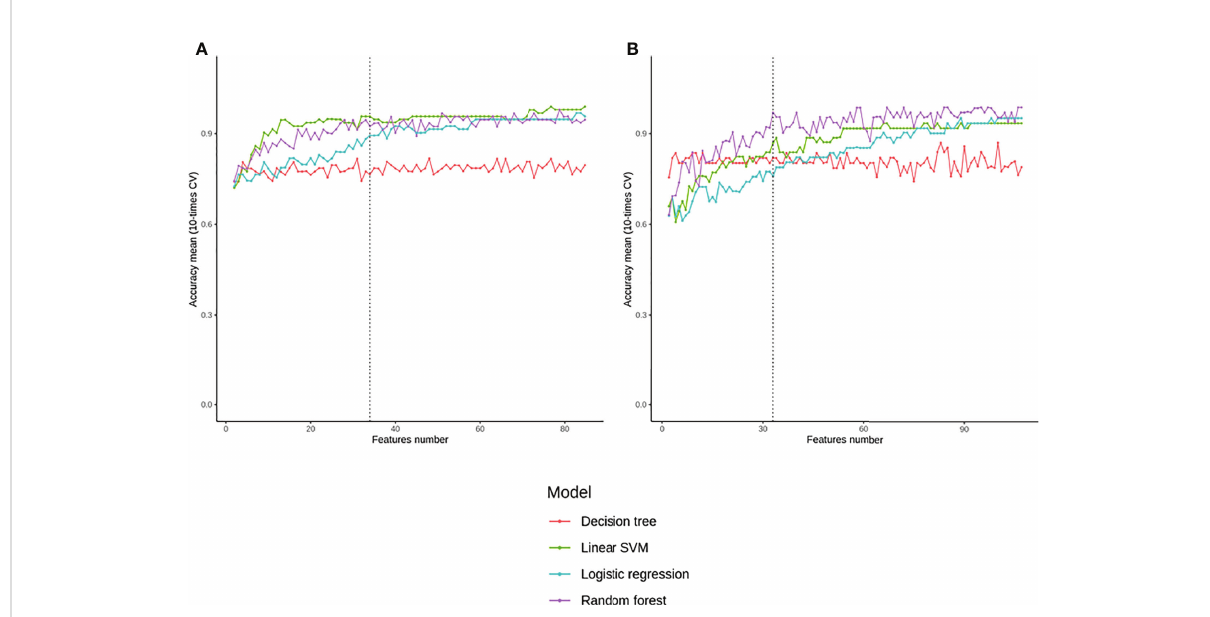
FIGURE 2 Evolution of the accuracy obtained with different machine learning models according to the number of top-explicative features chosen for (A) predict CCC or (B) predict CCC stage.